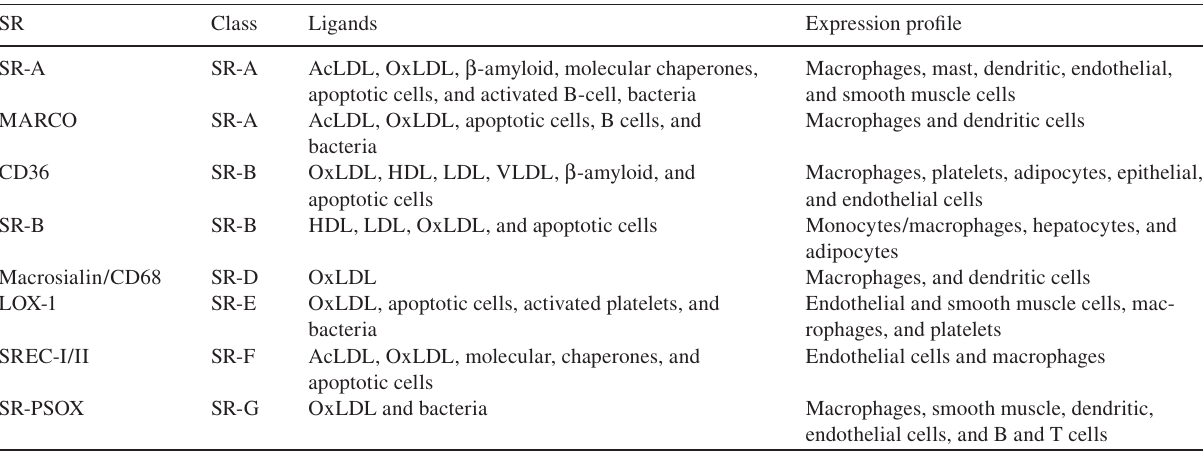
Table 1 Major SR and their ligands and expression profi